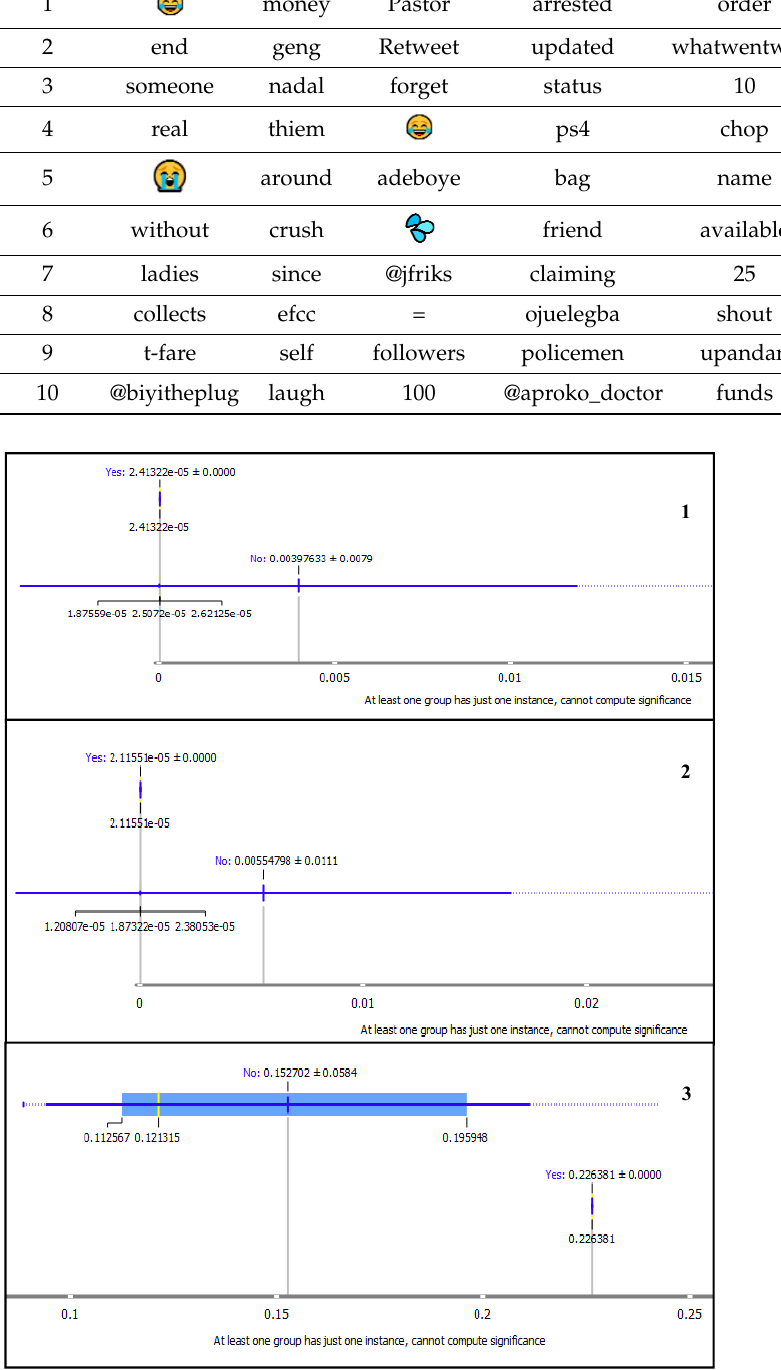
Figure 11. Box plots showing Marginal Topic Probability of the topics 1, 2, and 3 using Latent Dirichlet Allocation (LDA).